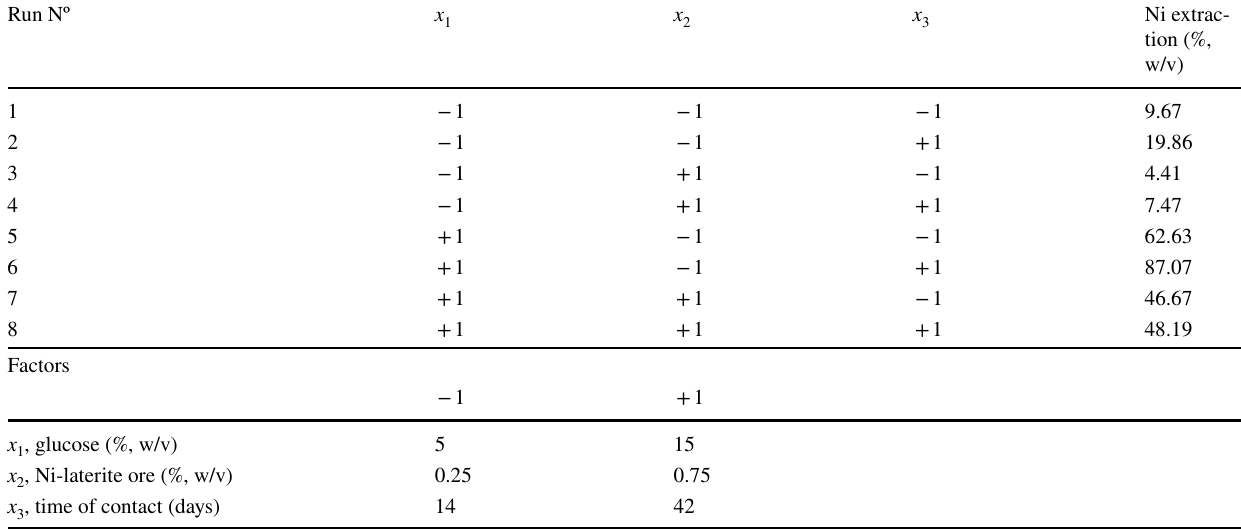
Table 2 2 3 Two-level full factorial design table defining conditions for Ni-laterite bioleaching by Burkholderia sp Run